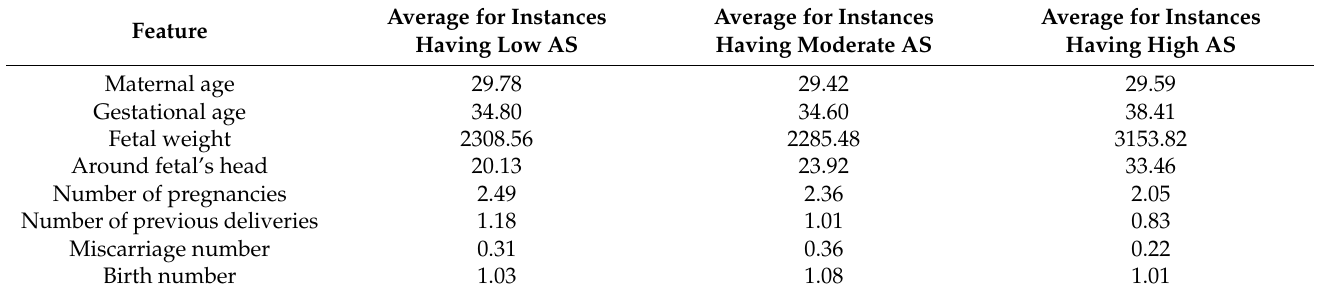
Table 2. The average of some numeric features for different classes of Apgar scores in our